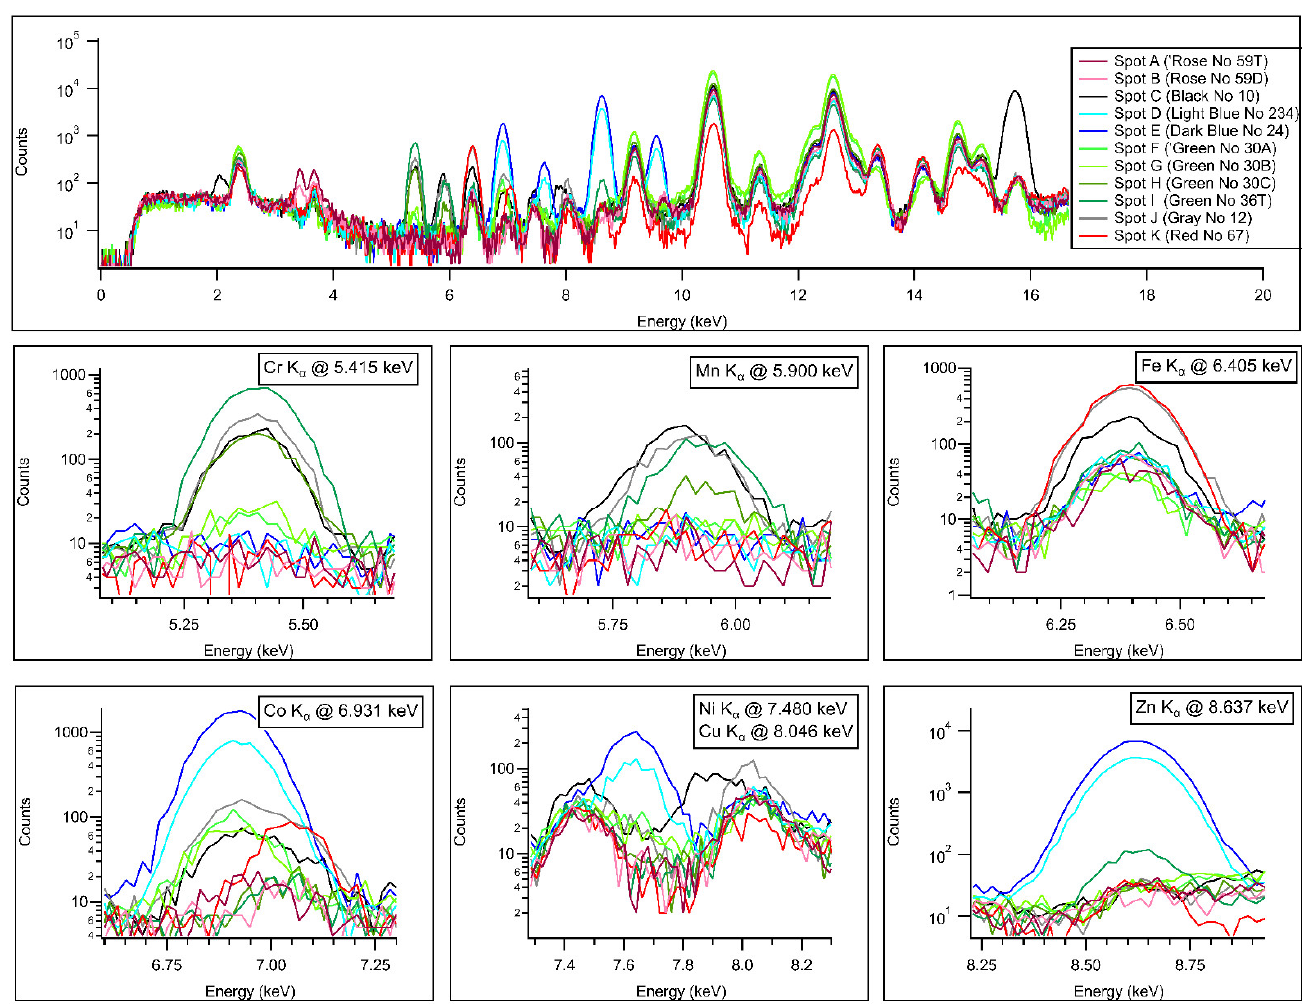
Figure 5. The K α analytical lines of Cr, Mn, Fe, Co, Ni, Cu, and Zn in the 5–9 keV region of the XRF spectra for the color palette.